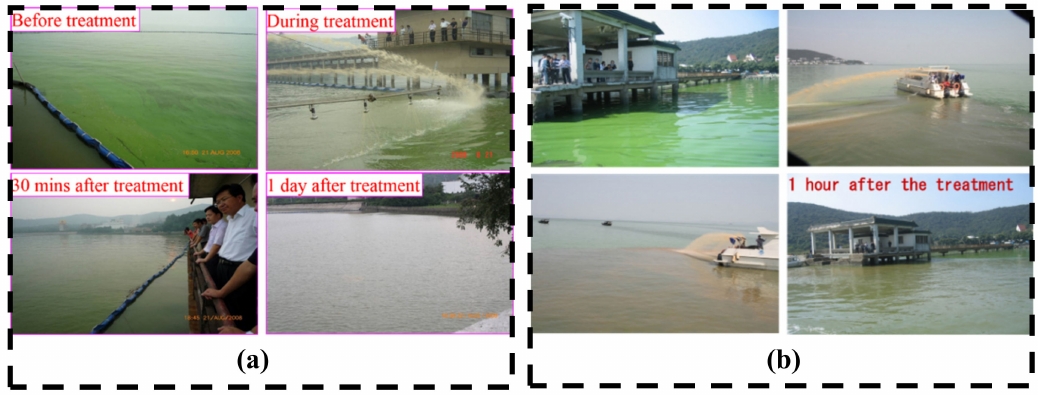
Figure 4. Application of MLS in ( a ) an enclosure with total area of 50,000 m 2 in Meiliang Bay in August 2008, and ( b ) in open water at Mashan Bay of Lake Tai in August 2009.